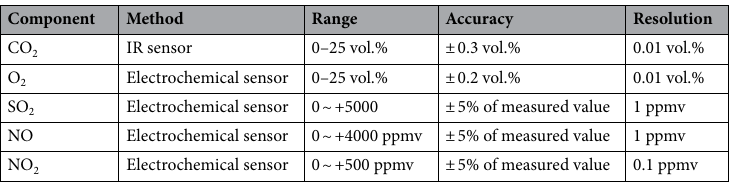
Table 2. Basis information of gas analyzer TESTO 350.